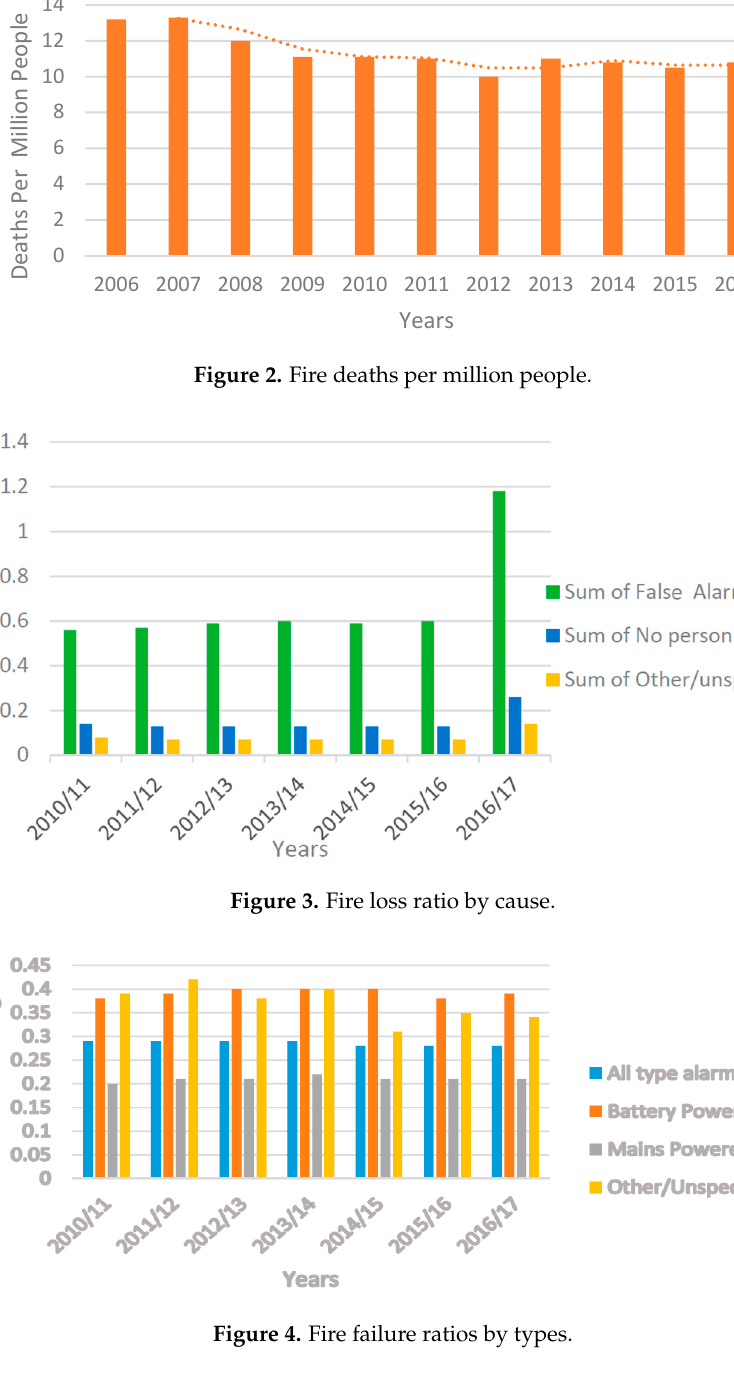
Figure 2. Fire deaths per million people.